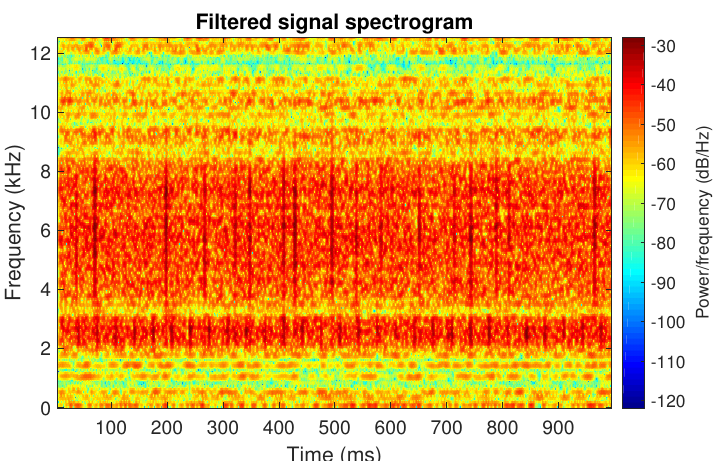
Figure 6. Spectrogram of filtered signal s 1 by Alpha